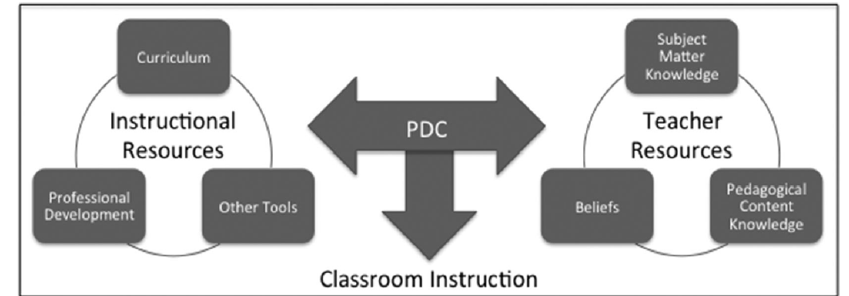
Framework for Pedagogical Design Capacity